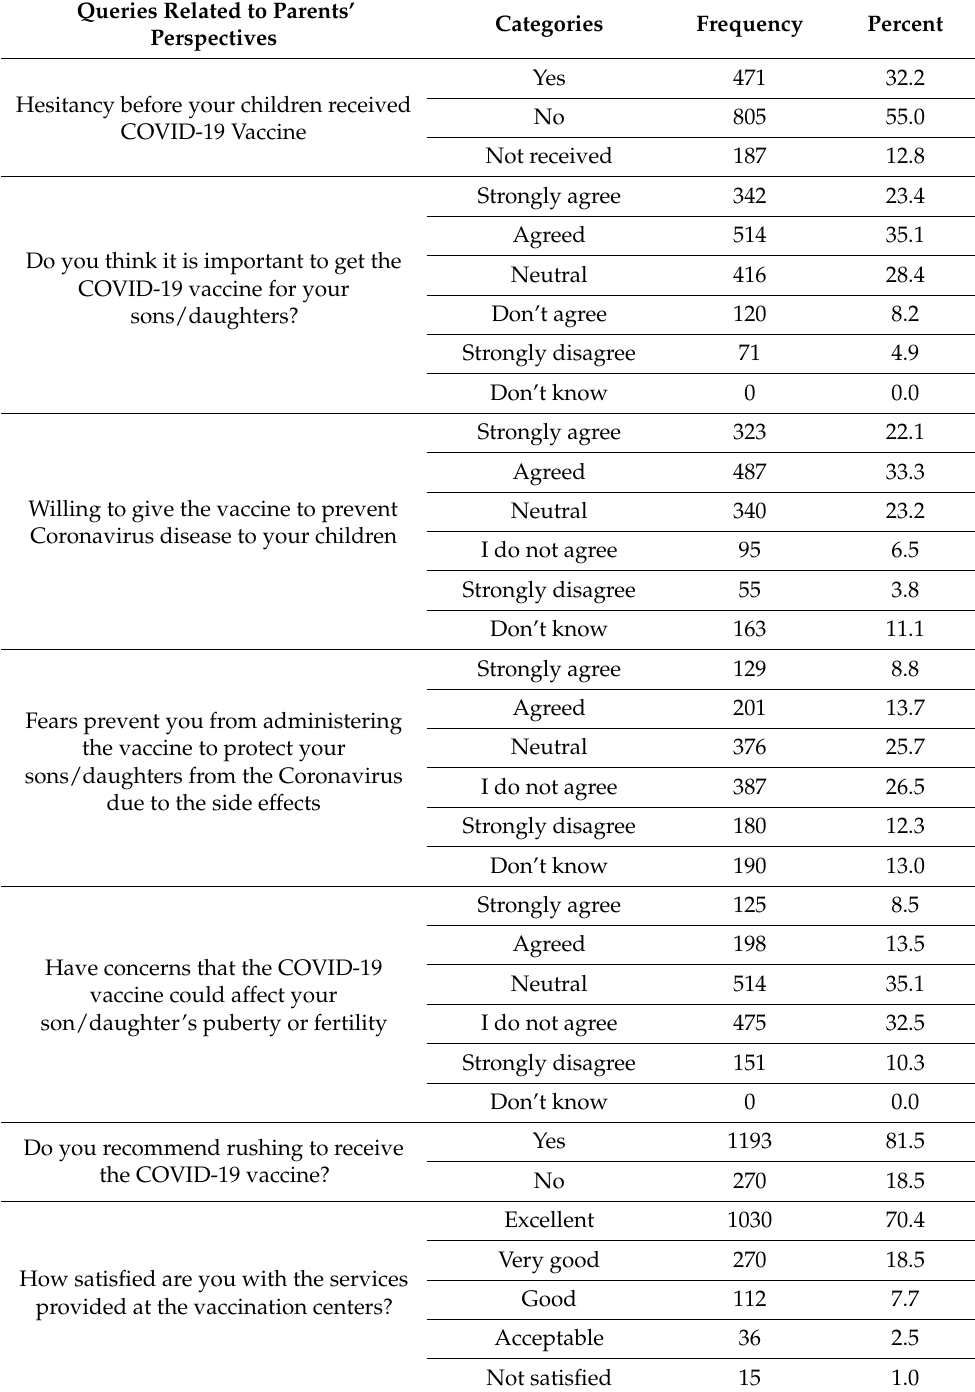
Table 2. Parent’s Perspectives on the COVID-19